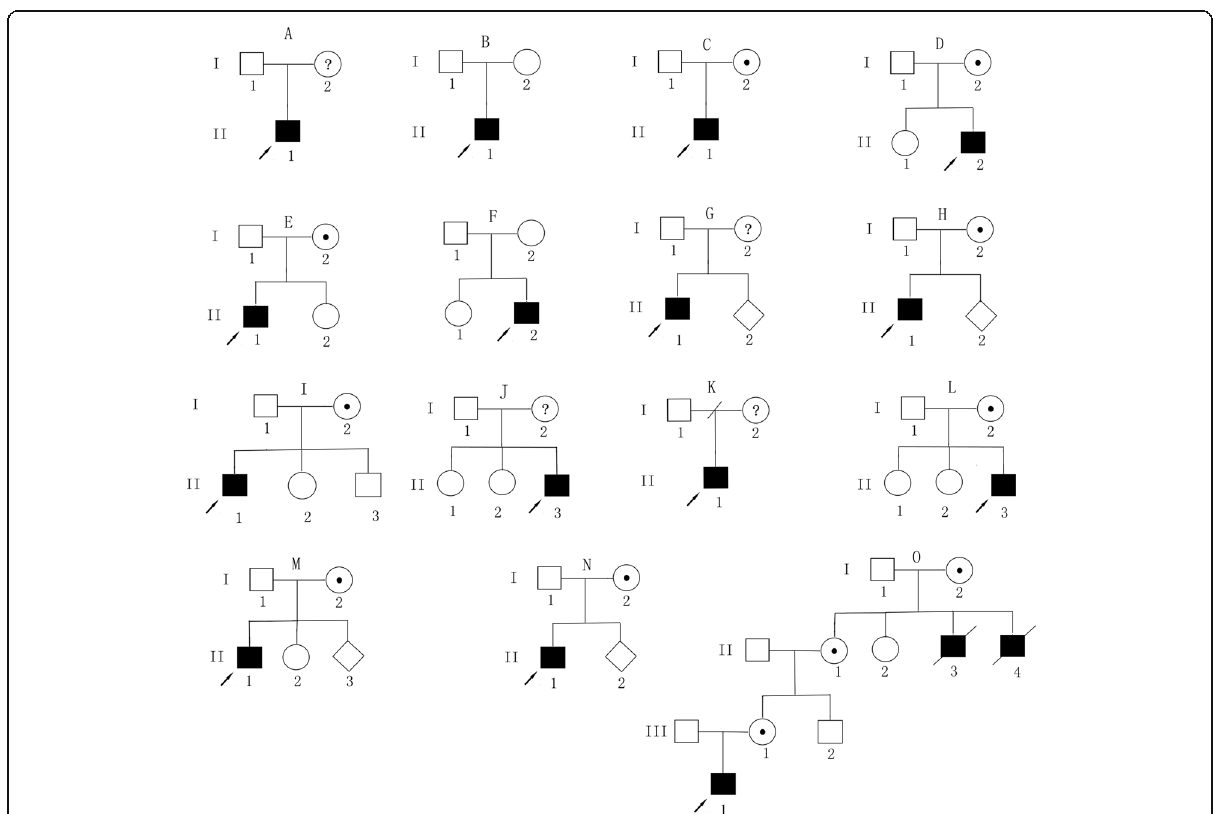
Fig. 1 Heredity map of the family with the proband. (Each letter (A-O) represents a type of the pedigree. The details can be found in the right- most column of Table